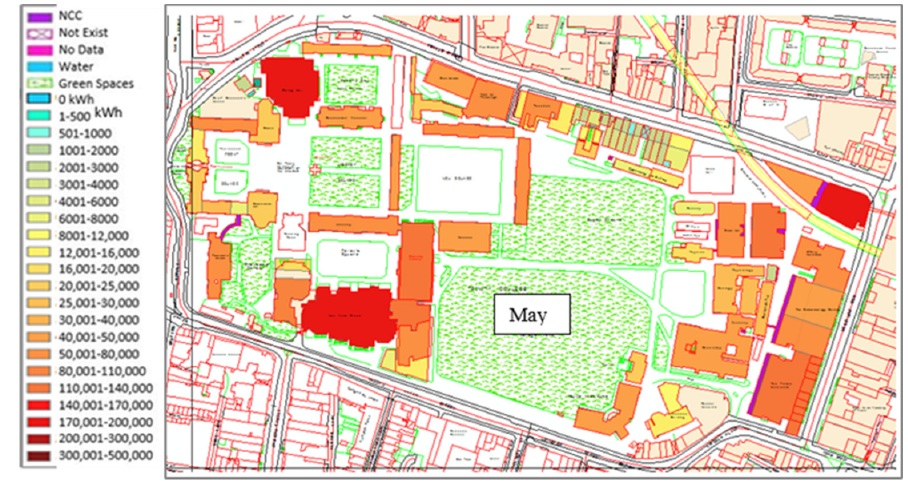
Figure 9. Heat demand map of May.